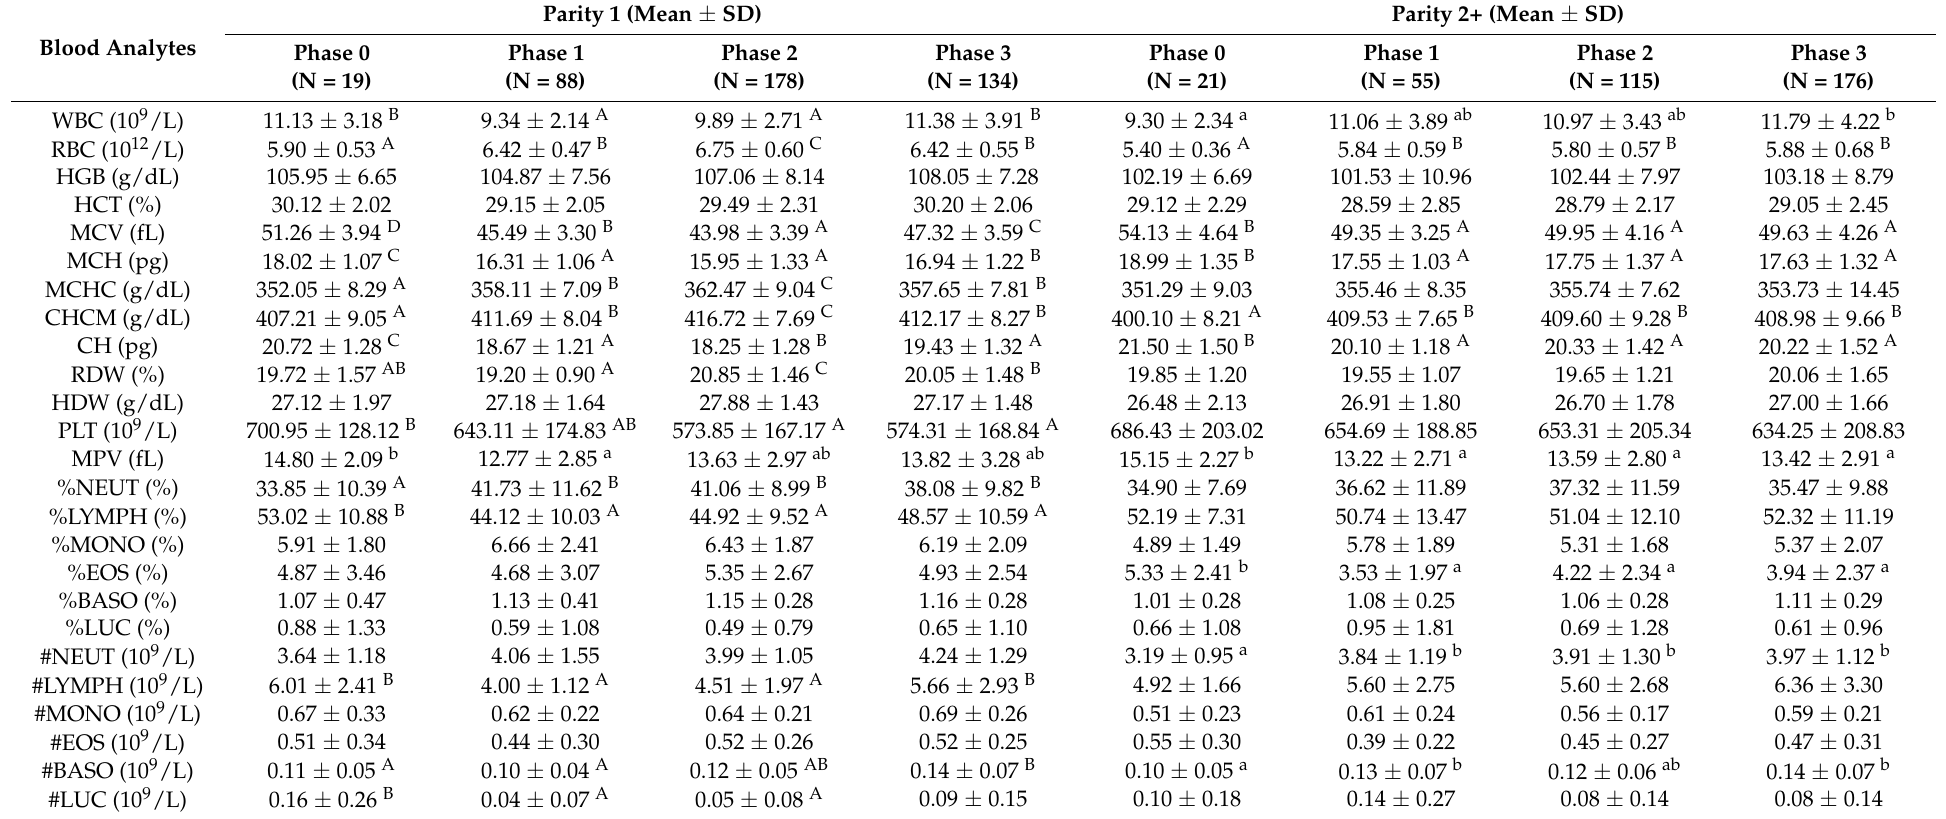
Table 5. Hematology values for Holstein cows when sorted by parities and lactation